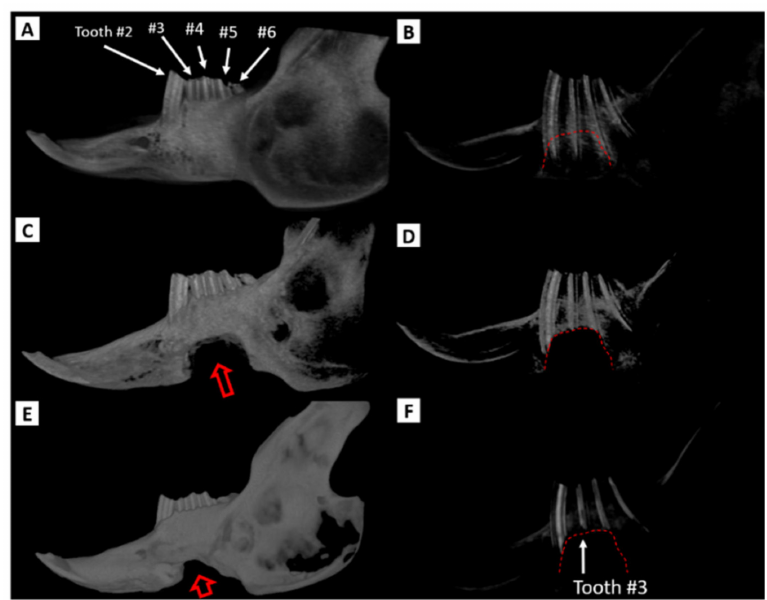
Figure 10. Reconstructed CBCT volumes of left rabbit mandible body defect (correlate with Table 1). The images on the left ( A , C , E ) highlight the surface anatomy of the left hemimandible. The images on the right ( B , D , F ) have been processed to display only the regions of high density thereby highlighting the cheek teeth (premolars & molars). ( A , B ): Left hemimandible prior to surgery. Teeth are labeled for orientation. Note the apices of the cheek teeth reserve crowns (roots) extend within millimeters of the inferior mandible border. ( C , D ): The hemimandible 1 week following the creation of a 10 × 12 mm defect along the inferior border of the tooth-bearing body of the mandible. ( E , F ): The hemimandible 10 weeks after defect creation. In ( C , E ) the red open arrow indicates the defect and in ( B , D , F ) the red dotted line outlines the original surgical defect. At 10 weeks the defect volume has decreased considerably (with bone deposition particularly notable in the vicinity of the reserve crowns) compared to one week while the erupted crowns appear shorter at 10 weeks than at baseline. Also note in image F the subtle resorption of reserve crown of tooth #3 in the 10-week scan (solid arrow). CBCT: cone beam computed tomography. Table 1. Length of cheek teeth in rabbit body defect. Measurements are only of the first 4 cheek teeth. The 5th tooth (#6) is not measured. Defect does not extend beyond tooth